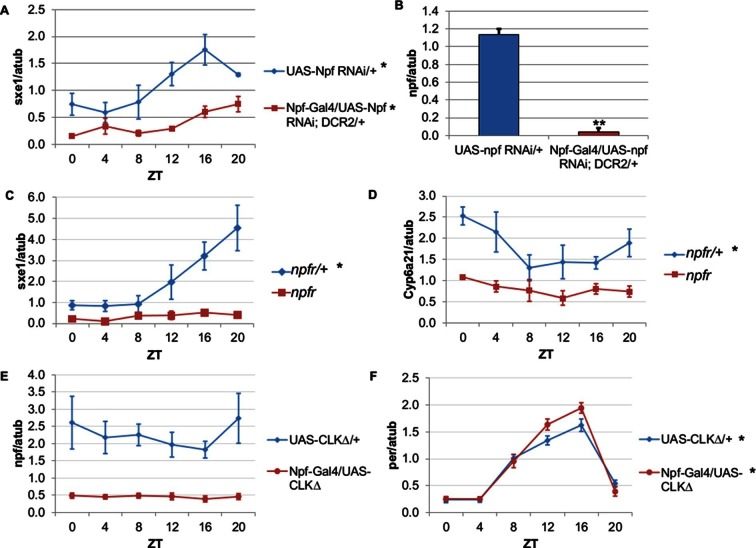
NPF is a critical circadian signal for sxe1 and Cyp6a21 rhythms in the fat body.(A) Knockdown of npf in all NPF-positive cells does not eliminate rhythmicity but reduces expression of sxe1 in the fat body at all times. (B) Analysis of npf knockdown efficiency in heads of Npf-GAL4/UAS-npf RNAi; DCR2 (UAS-Dicer2) flies showed a significant reduction in npf levels by Student’s t-test (**p<0.001). (C, D) sxe1 and Cyp6a21 expression in the fat body are reduced and do not cycle in homozygous npfr mutants compared to heterozygous controls. (E) npf levels in the heads of Npf-GAL4/UAS-CLKΔ are reduced compared to controls (UAS-CLKΔ/+). (F) Total per levels are not altered in the heads of Npf-GAL4/UAS-CLKΔ compared to controls. Each experiment was repeated independently three times except for (B) which n=6 for each genotype. The average value ± SEM for each timepoint is plotted. JTK_cycle p value <0.05 is indicated by an asterisk (*) next to the genotype label. See Table 3 for JTK_cycle p values. ZT- Zeitgeber Time.DOI:
http://dx.doi.org/10.7554/eLife.13552.01110.7554/eLife.13552.012Figure 4—source data 1.Data for qPCR analysis of fat body clock-independent genes and clock genes in flies with perturbed NPF signaling.